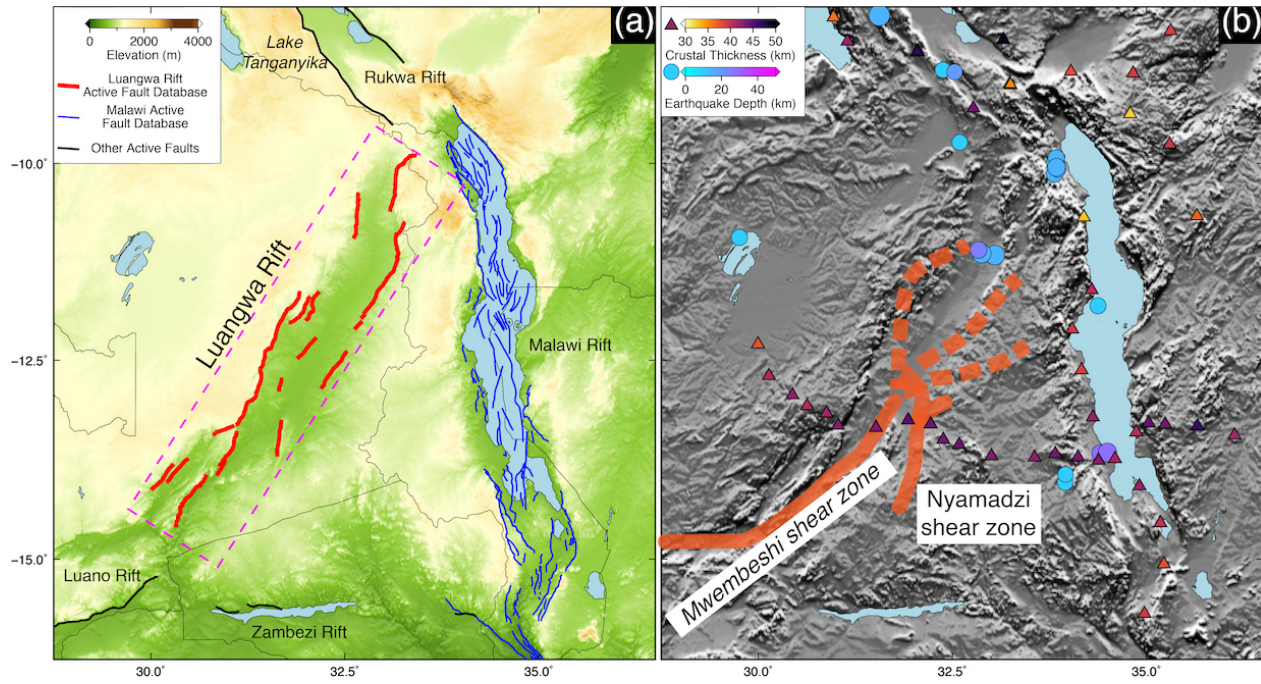
Figure 2. The Luangwa Rift and the intersection between southwestern and western branches of the EARS showing major faults. (a) The faults in the LRAFD are shown with red lines, the Malawi Active Fault Database (MAFD) active fault traces are shown with blue lines (Williams et al., 2022), and other active border faults are outlined in black (Chorowicz, 2005). (b) Seismicity ( M w > 5 . 2 from the ISC-GEM catalogue), crustal thickness (from receiver function measurements; Sun et al., 2021), and the location of major lithospheric-scale shear zones beneath the Luangwa Rift (adapted from Daly et al., 1989; Johnson et al., 2006; Alessio et al.,